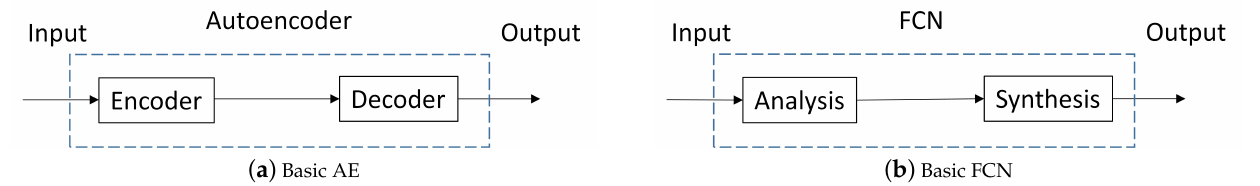
Figure 1. The structure of basic AE and FCN: ( a ) Basic AE contains an encoder and a decoder; ( b ) Basic FCN consists of analysis network and synthesis